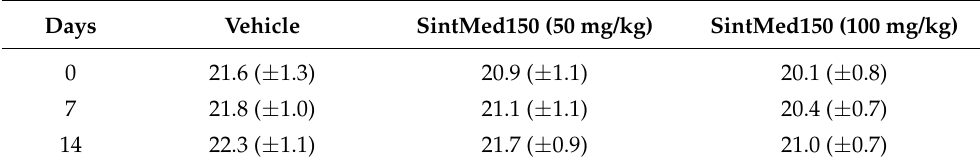
Table 3. Body weight of BALB/c mice treated with the compound SintMed150